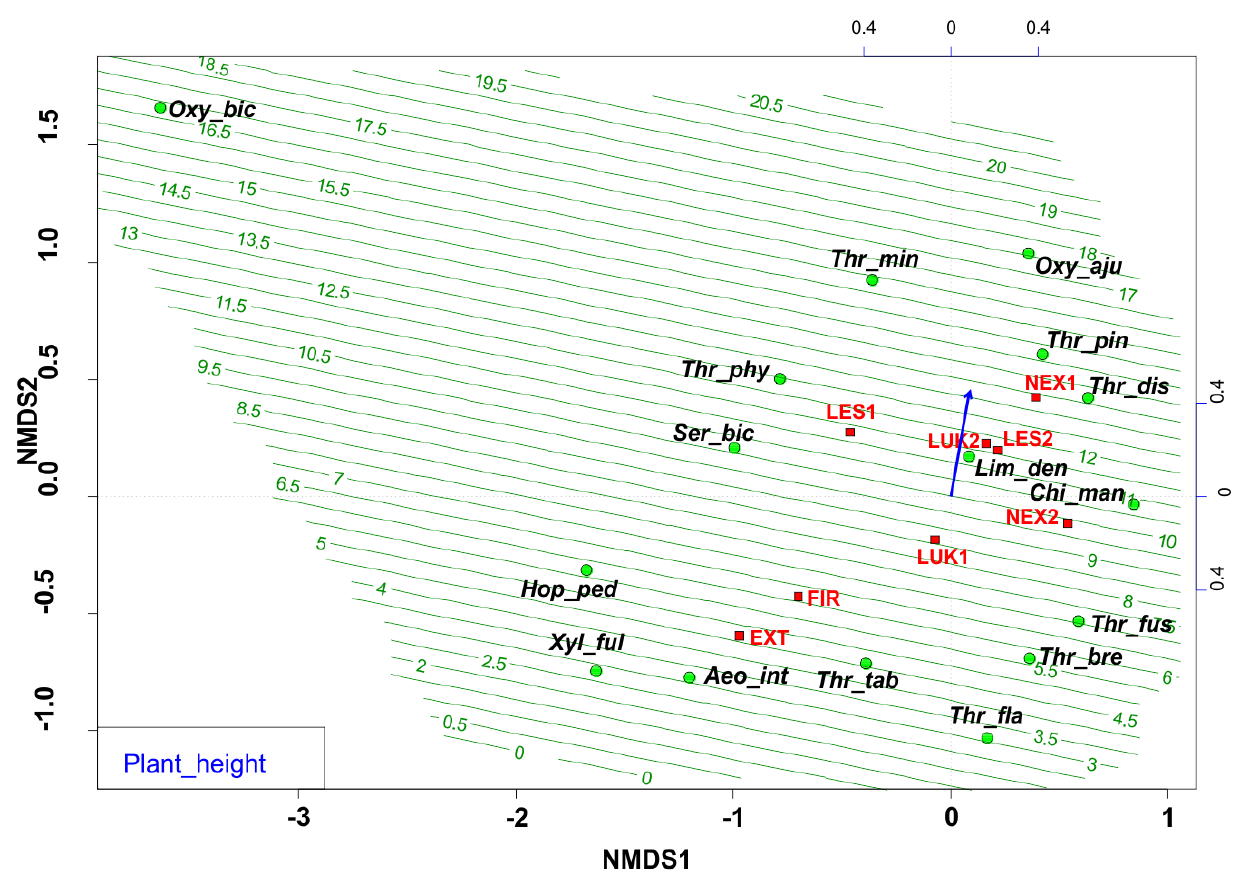
Figure 3. Nonmetric multidimensional scaling (NMDS) plot showing the relatedness of the thrips assemblages between the different samples and study plots (EXT, FIR, NEX1, NEX2, LUK1, LUK2, LES1, LES2) and the plant height of the present plant community. Oxy_bic– Oxythrips bicolor ,